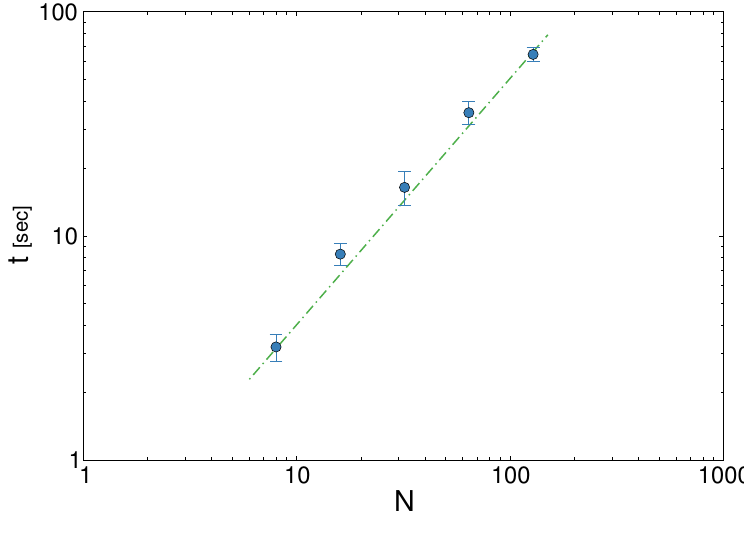
Figure 3. The running time t of the weighted Belief Propagation (wBP) algorithm vs . the number of reactions, N . For each value of N , we average here over 10 random synthetic metabolic networks, each having M = N/ 2 metabolites. The algorithm (blue circles) scales linearly with the system size; a linear function, t ∝ N (green dashed line), is plotted to guide the